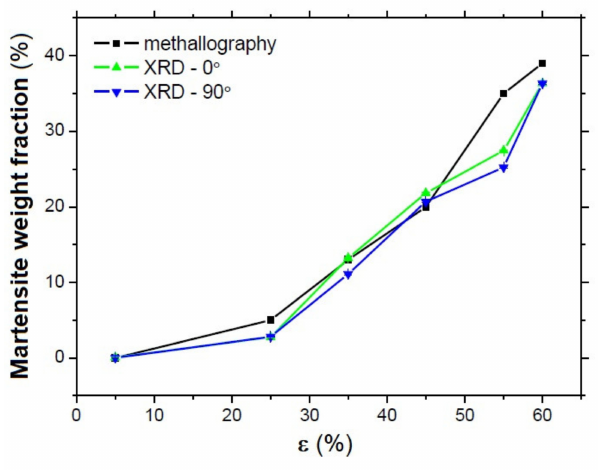
Figure 6. Martensite weight fraction versus ε